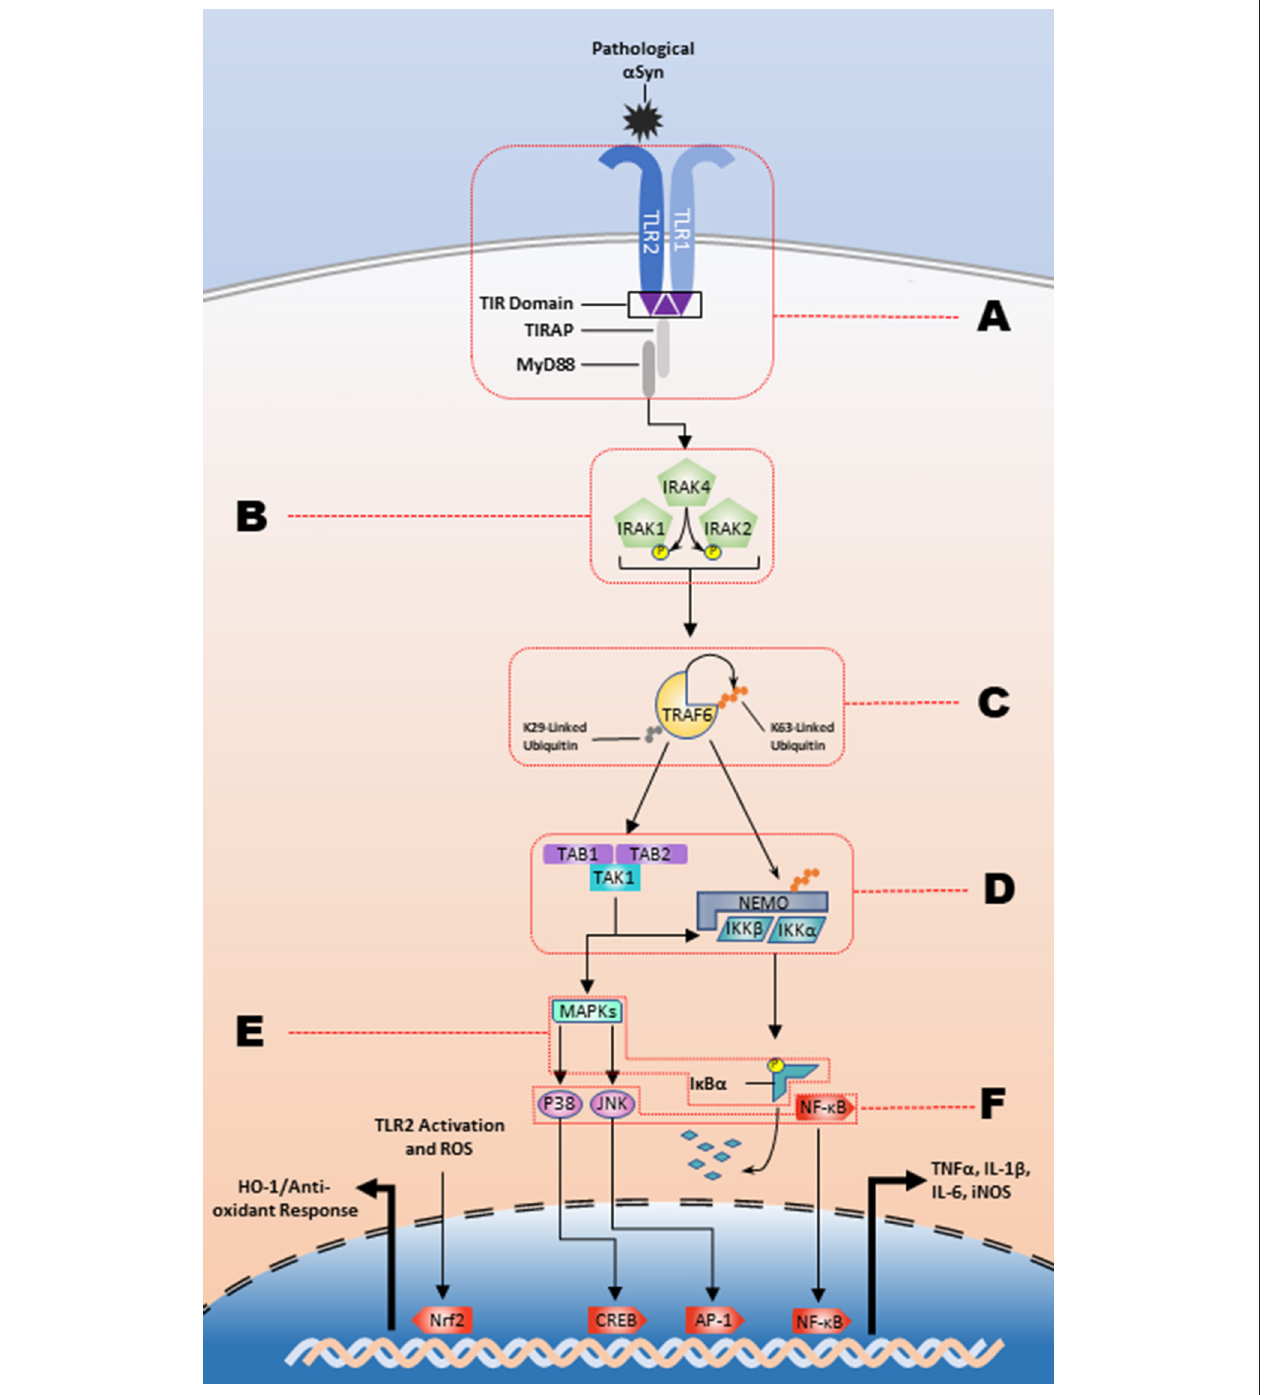
FIGURE 1 | The TLR2/1 signaling cascade and respective regulatory nodes. α Syn binding to the TLR2/1 heterodimer leads to a MyD88-dependent response that stimulates the kinase activity of the IRAK complex. The IRAK complex in turn activates TRAF6 K63-linked auto-ubiquitination, which subsequently leads to the release of the IKKs and activation of TAK1. The IKKs will designate I κ B α for degradation and TAK1 will stimulate the MAPK pathway leading to the NF- κ B, JNK, and p38 nuclear translocation to upregulate proinflammatory cytokines. There are several potential regulatory nodes and letters A-F represent those targets for intervention along the signaling pathway in order to impede